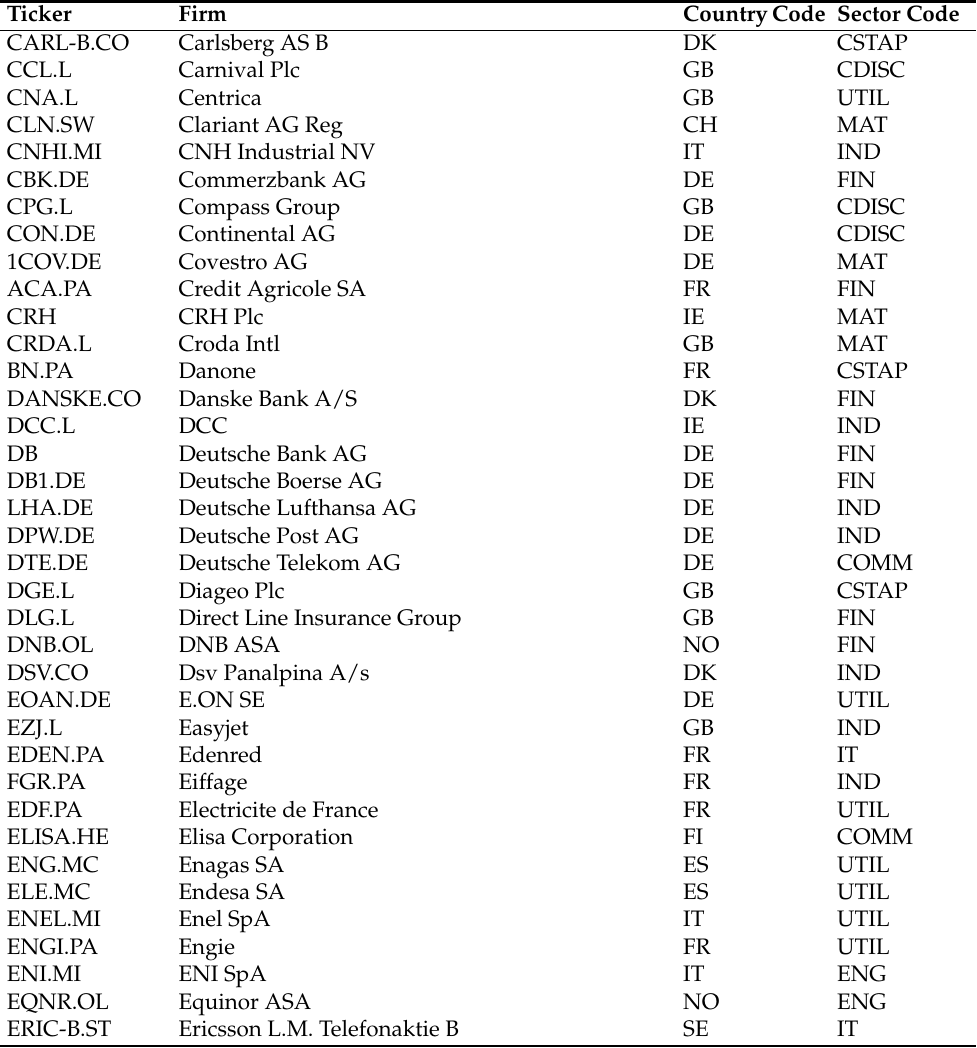
Table A5. Cont. Ticker